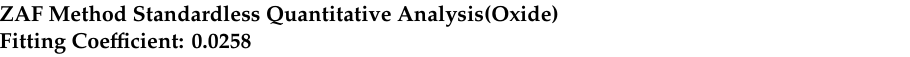
Table 11. The Oxide of resin reinforced Kenaf ( Hibiscus cannabinus ).